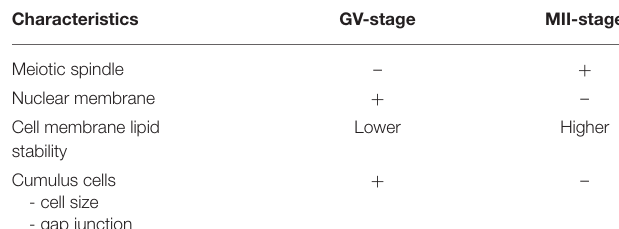
TABLE 1 | Different characteristics of oocyte between GV- and MII-